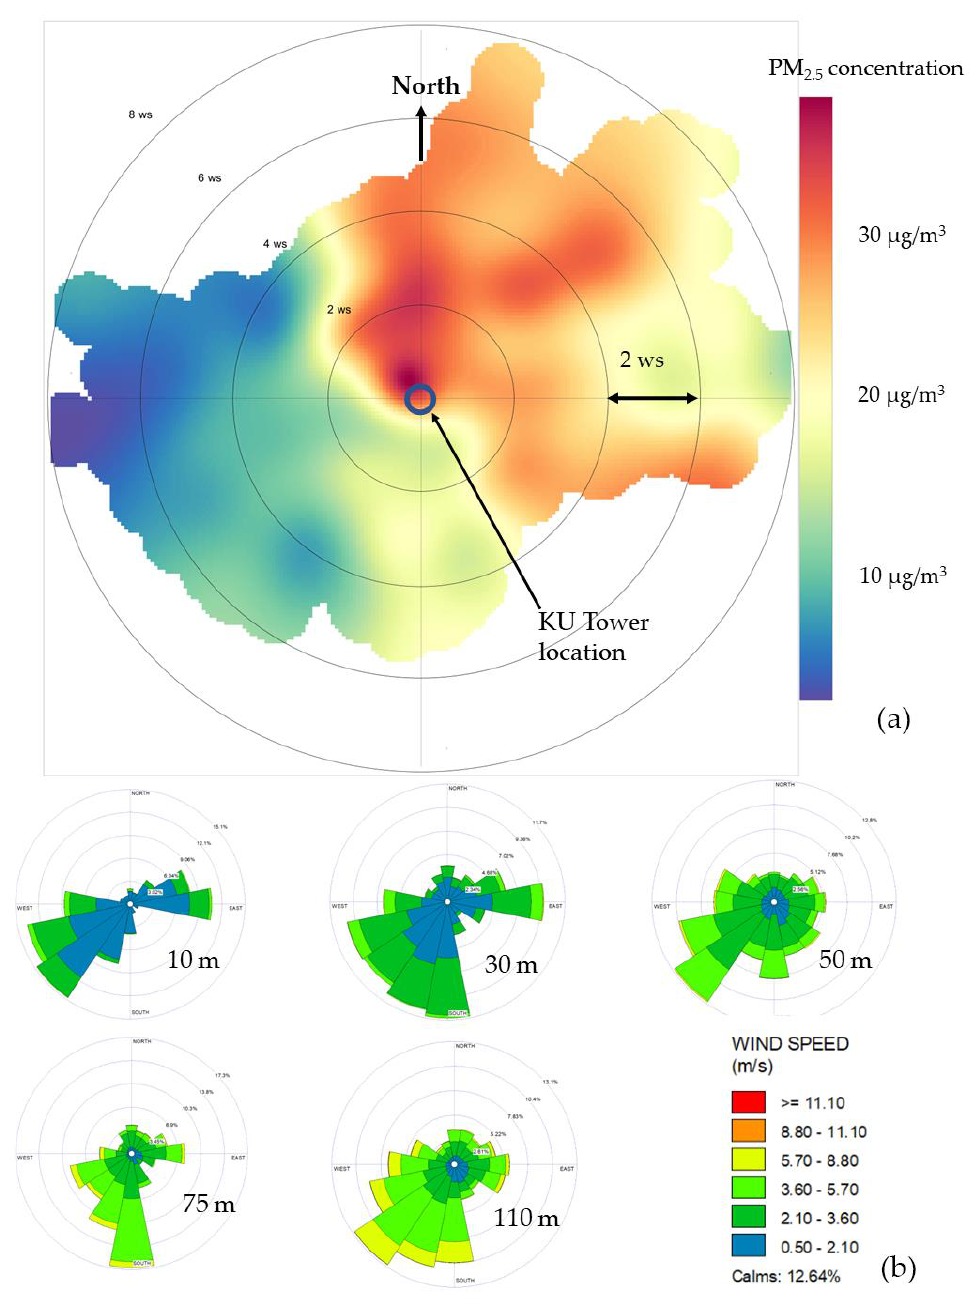
Figure 4. Polar plot of actual PM 2.5 concentrations measured at 30 m ( a ), averaged over the years 2015–2020, and the corresponding wind direction and wind speed distribution measured at the KU tower at the indicated levels (b).